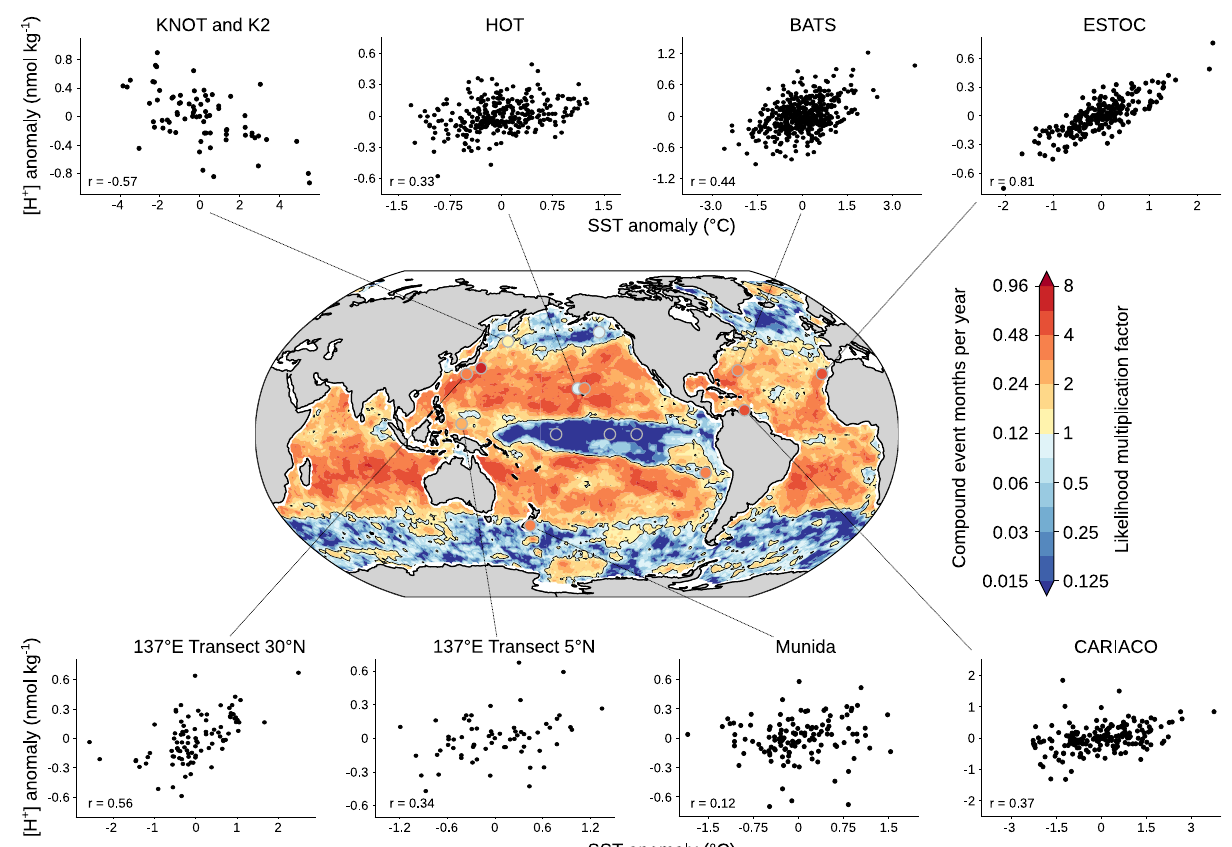
Fig. 1 | The observation-based likelihood multiplication factor of compound MHW-OAXeventsovertheyears1982 – 2019. Mapofthelikelihoodmultiplication factor (LMF) based on the global monthly gridded observation-based SST and surface [H + ] data. The baseline period 1982 – 2019 was used to de fi ne the extreme events. Warm colors indicate LMF>1 and cold colors indicate LMF<1. These regionsareseparatedbythethingraycontourline.Thecolorbaralsoindicatesthe